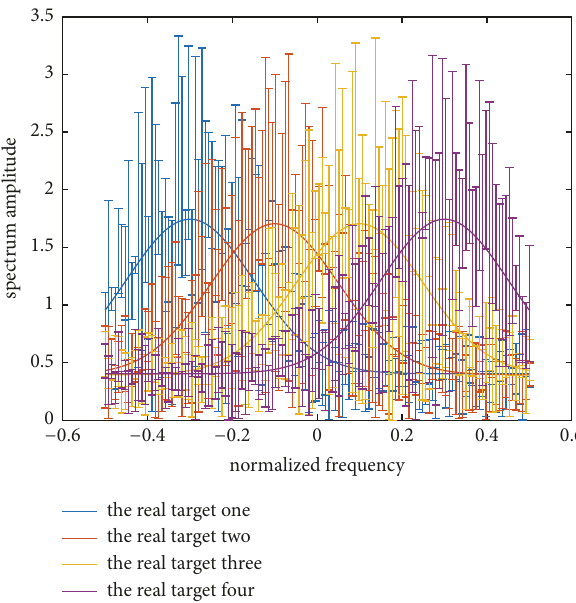
Figure 5: Bounded multitarget spectrum